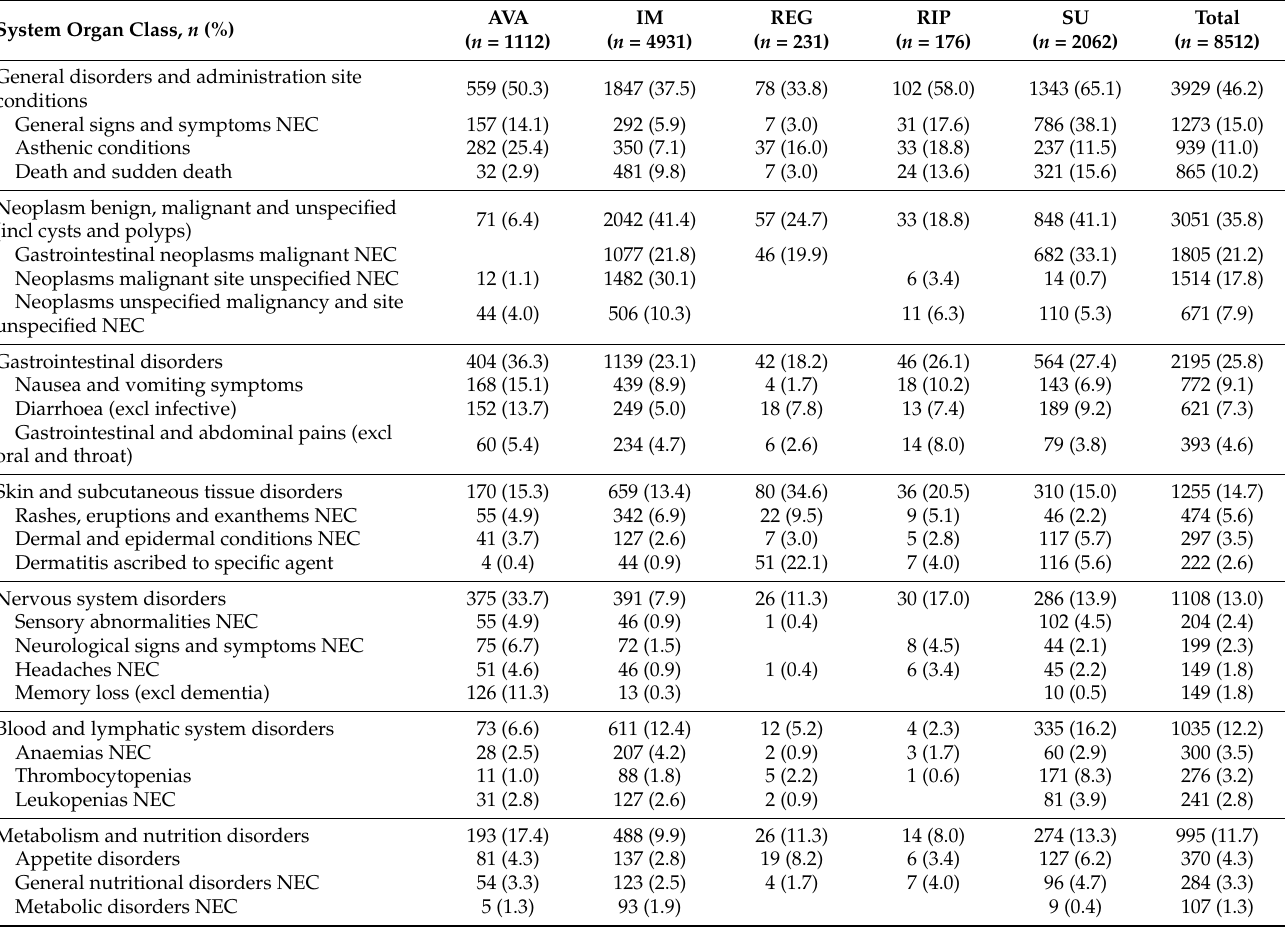
Table 2. Distribution of main ADRs by MedDRA SOC and the top three HLTs within each SOC.